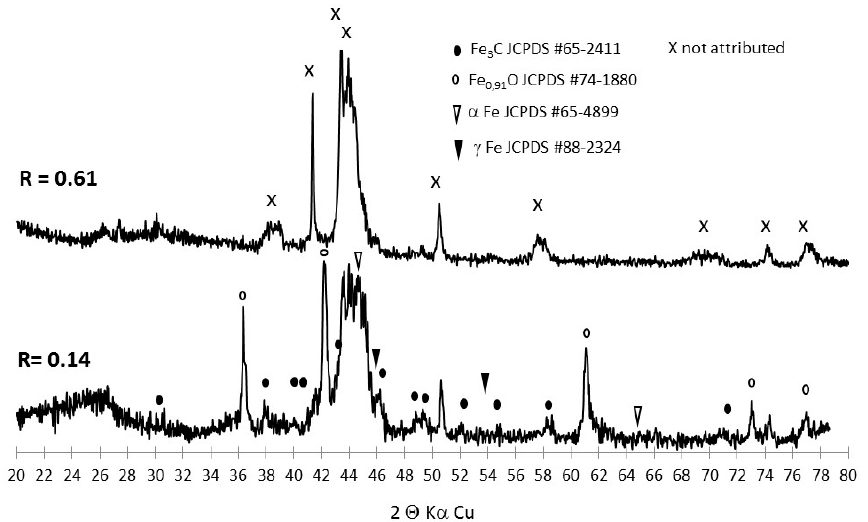
Figure 7. XRD diffraction patterns recorded on powders synthesized using LMP-1 for high and low R values. Phases identified by Mossbauer spectroscopy are indicated on the patterns, together with unattributed peaks.